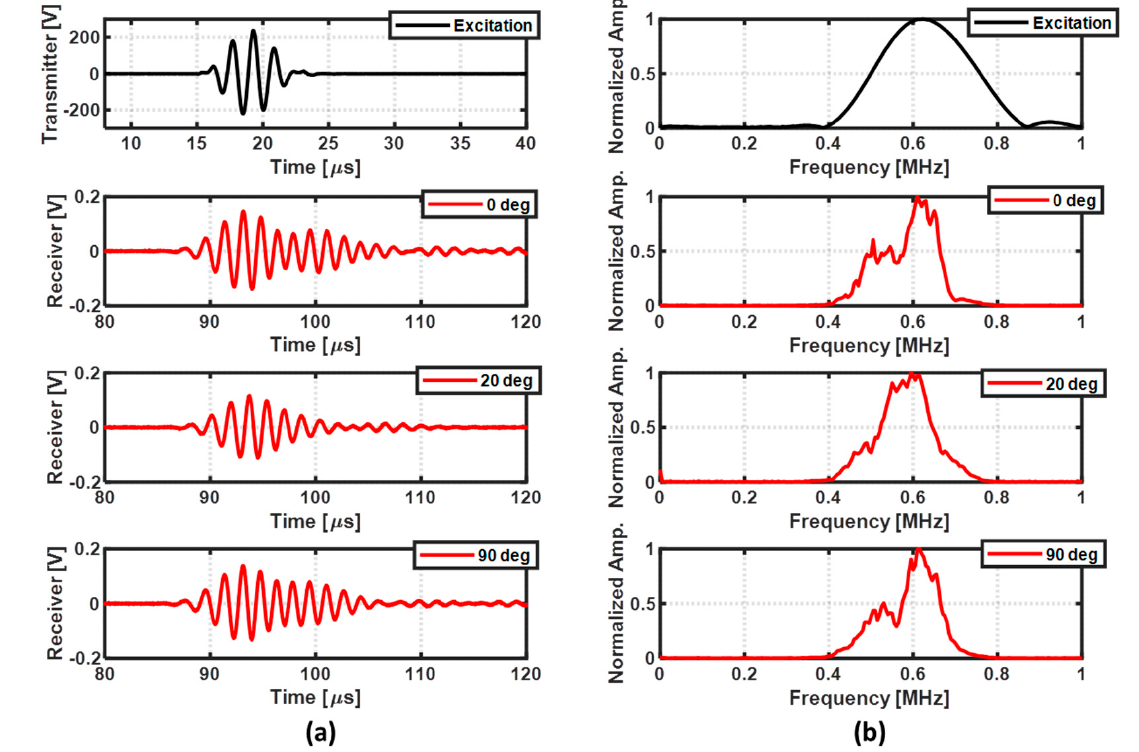
Figure 6. Acquisition of the transmitter and receiver signals when the direction of the pair of transducers was set to 0°, 20°, and 90° in a damage − free region: ( a ) time domain signals and ( b ) normalized amplitude spectrum.